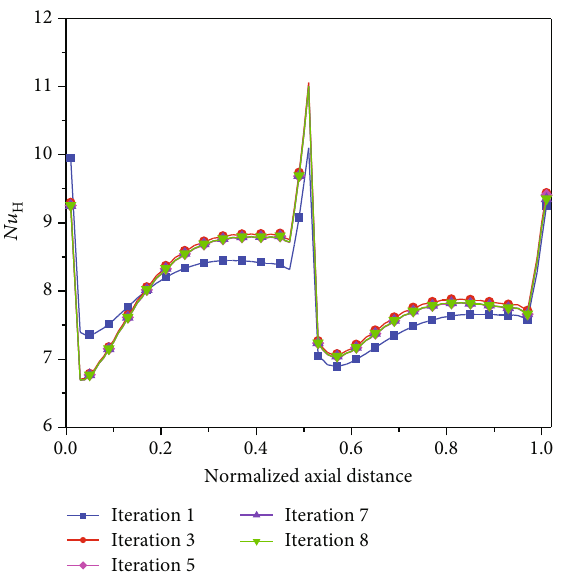
Figure 10: Local perimeter averaged Nusselt number in the streamwise direction for iterations 1, 3, 5, 7, and